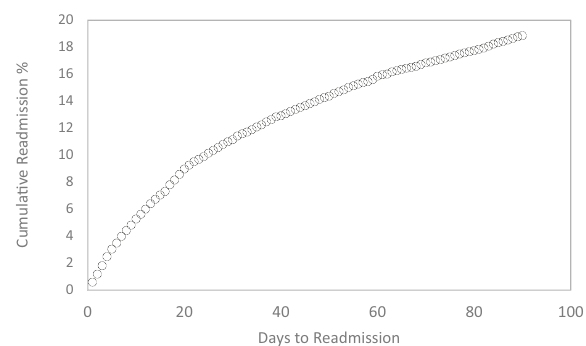
Fig. 1 Cumulative readmission rate by days to readmission after hospital discharge. Circle symbols indicate the cumulative read- mission percentage (%) from 0 to 90 days after hospital